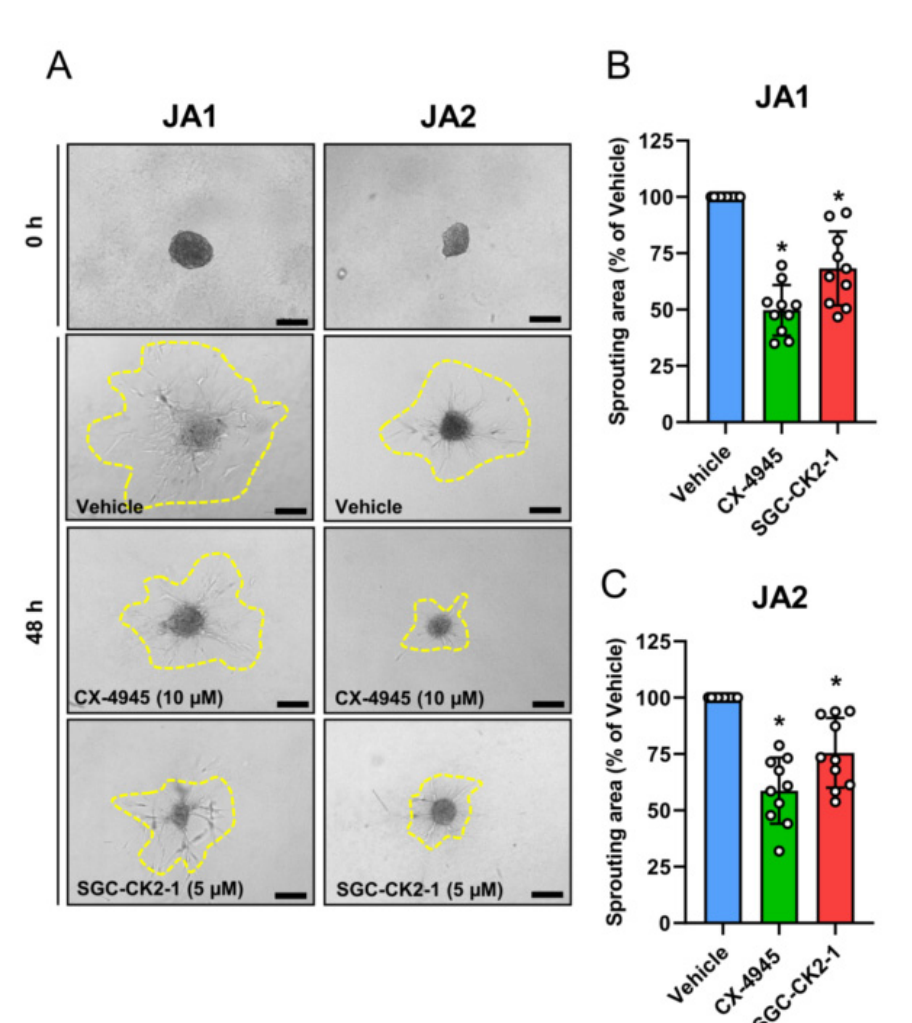
Figure 5. CK2 inhibition reduces the migratory activity of the patient-derived JA cells. ( A ) The JA1 and JA2 cells were cultivated by means of the liquid overlay technique for 24 h and the resulting spheroids were embedded into a collagen matrix. Bright field images of the sprouting area around the spheroids (the border marked by a broken yellow line) were taken immediately after embedding (0 h) and 48 h after treatment with the vehicle, CX-4945 (10 µM) and SGC-CK2-1 (5 µM). Scale bars: 100 µm. ( B , C ) The sprouting area was assessed 48 h after the treatment of the JA1 ( B ) and JA2 ( C ) spheroids with the vehicle, CX-4945 (10 µM) and SGC-CK2-1 (5 µM). Data are expressed as a % of the vehicle-treated spheroids. Mean ± SD ( n = 10). * p < 0.05 vs. vehicle.